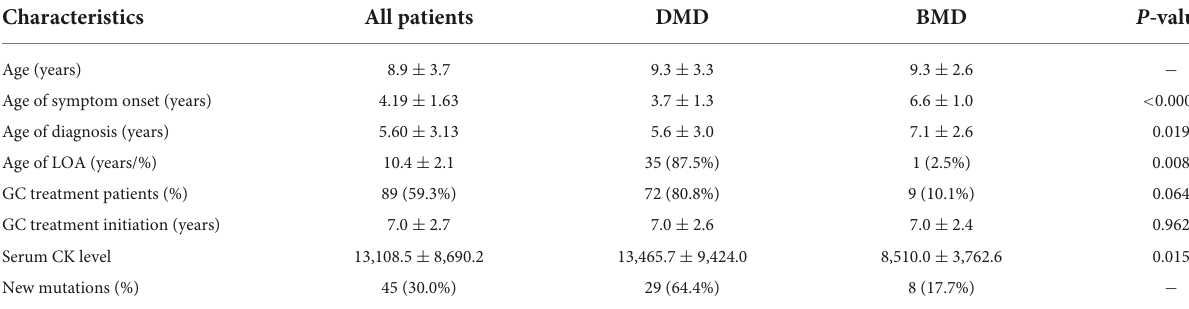
TABLE 1 Clinical characteristics of Duchenne muscular dystrophy/Becker muscular dystrophy (DMD/BMD) with small mutation. Characteristics